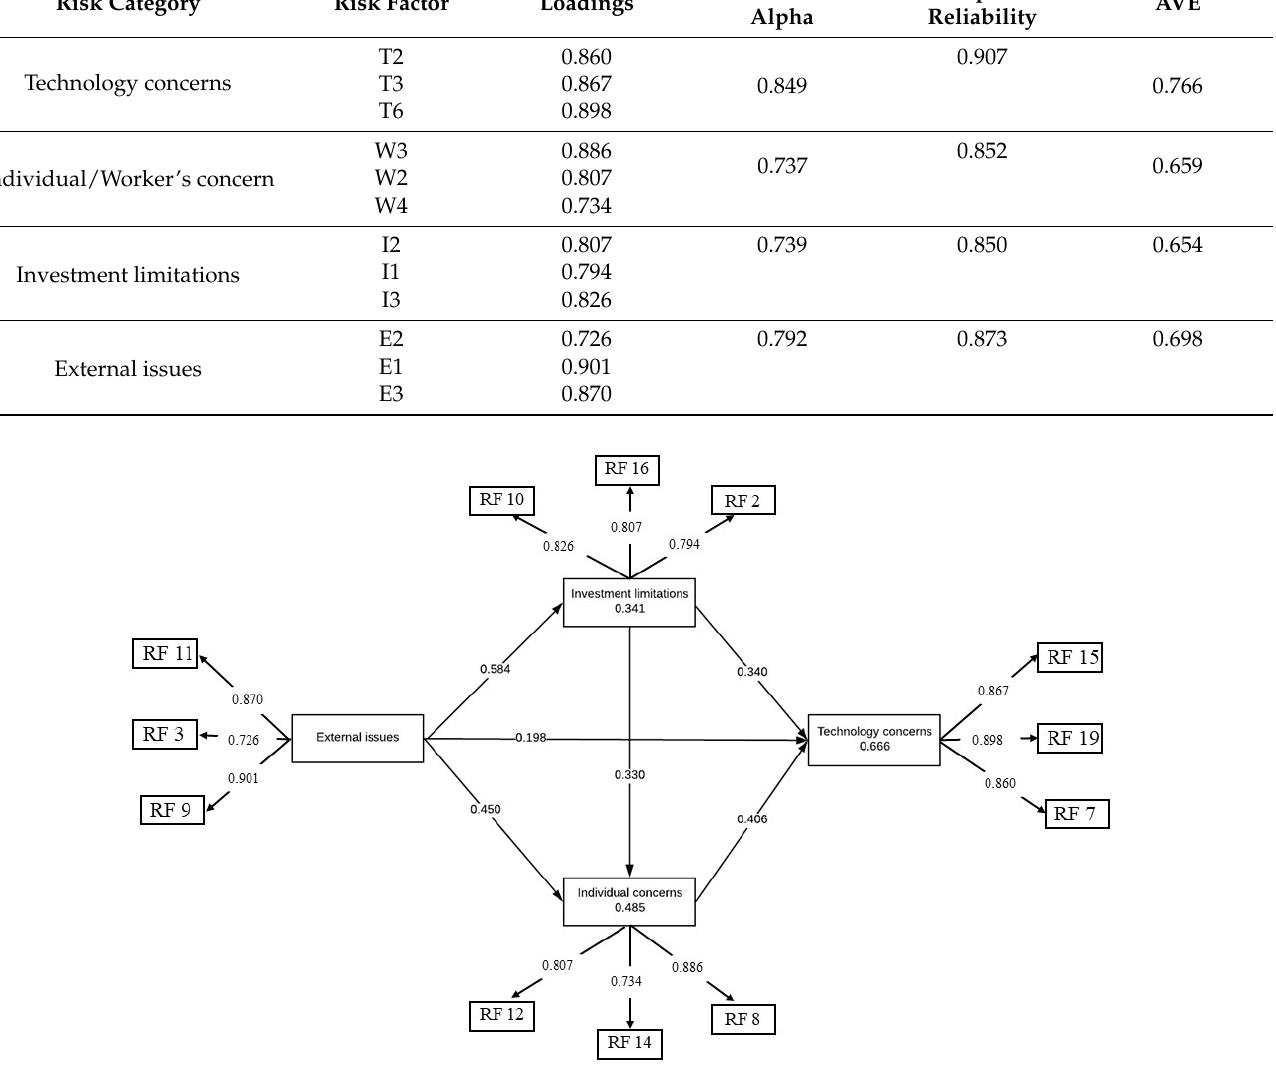
Figure 5. Final model for the networking of risk criticality path in the implementation of immersive technologies using PLS algorithm calculations.